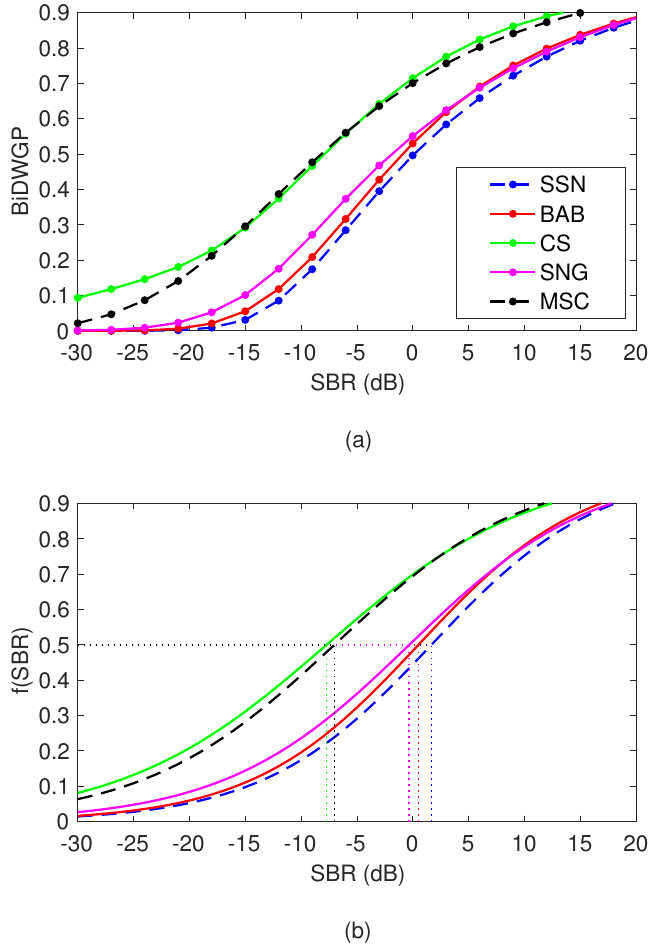
Figure 4. ( a ): Mean BiDWGP as a function of SBR. ( b ): A two-parameter logistic function fitted to the data in the upper panel. Speech produced by Talker F6 in different background sounds. The dotted lines in the lower panel indicate the SBR required for a BiDWGP score of 0.5 in each